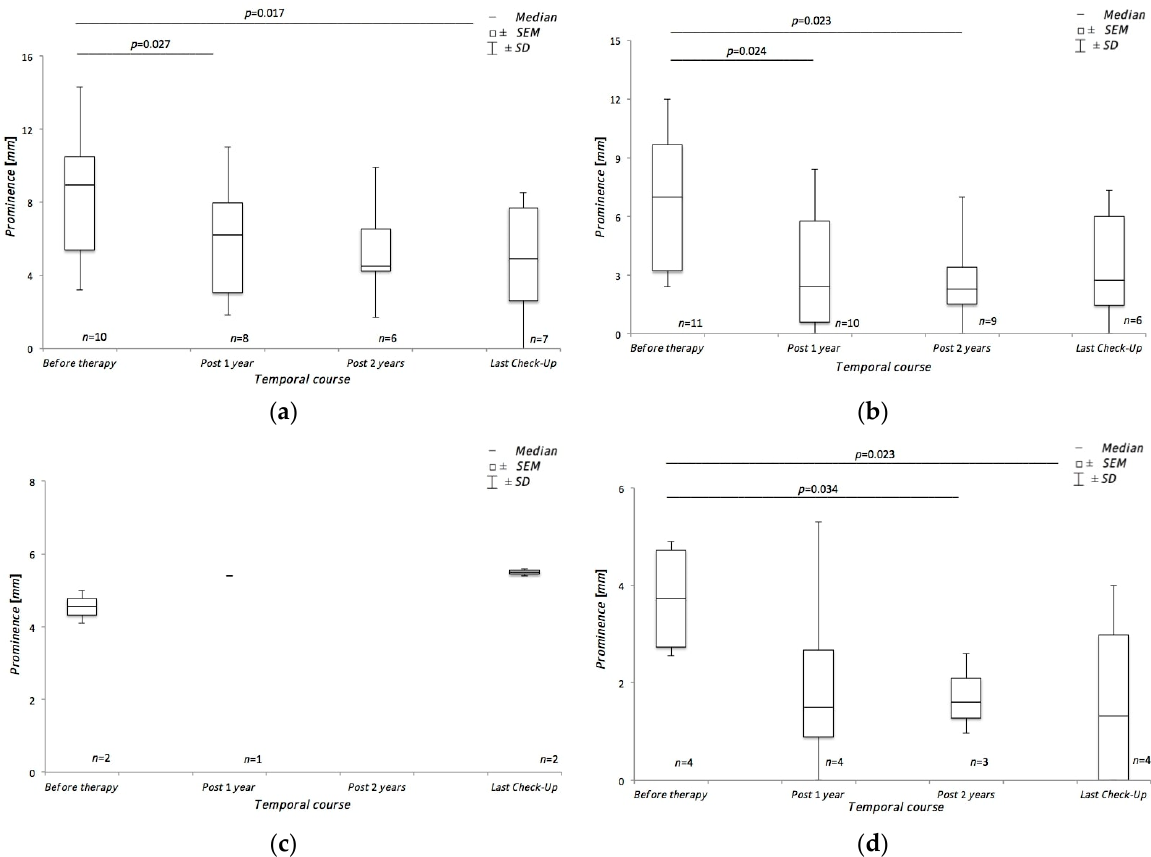
Figure 3. Course of tumor height during treatment. ( a ) shows the course of tumor prominence during treatment using CDFI in patients treated with CyberKnife®. ( b ) The figure shows the course of tumor prominence during treatment using bulbar sonography in patients treated with CyberKnife ® . ( c ) The figure shows the course of tumor prominence during treatment using CDFI in patients treated with ruthenium-106 brachytherapy. ( d ) The figure shows the course of tumor prominence during treatment using bulbar sonography in patients treated with ruthenium-106 brachytherapy.